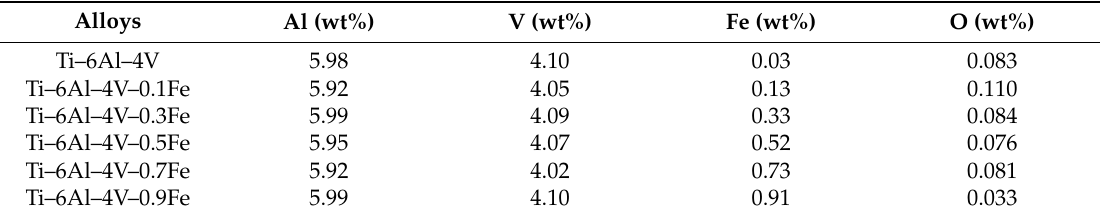
Table 2. Mass fraction of each